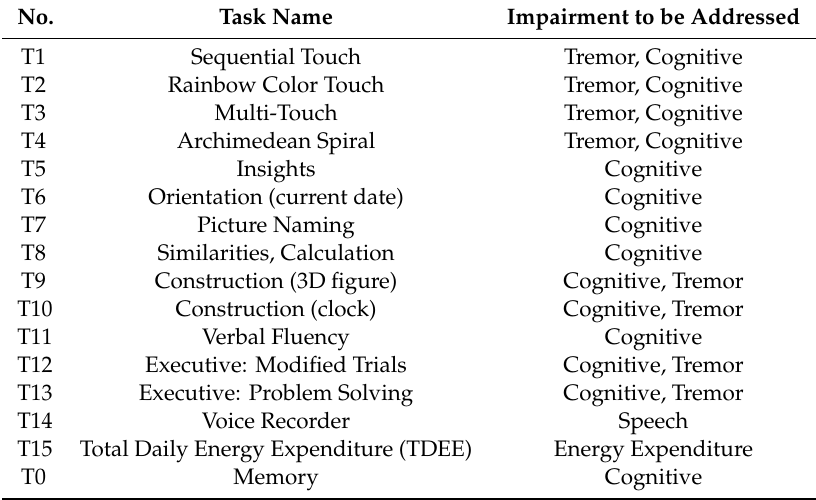
Table 1. List of all available tasks in the mobile